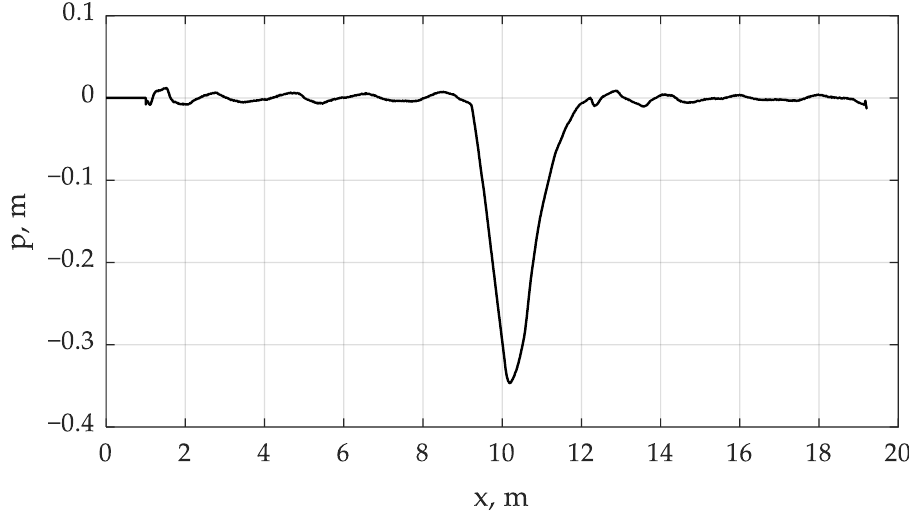
Figure 8. The difference in the positions of points O and W of the vehicle p.